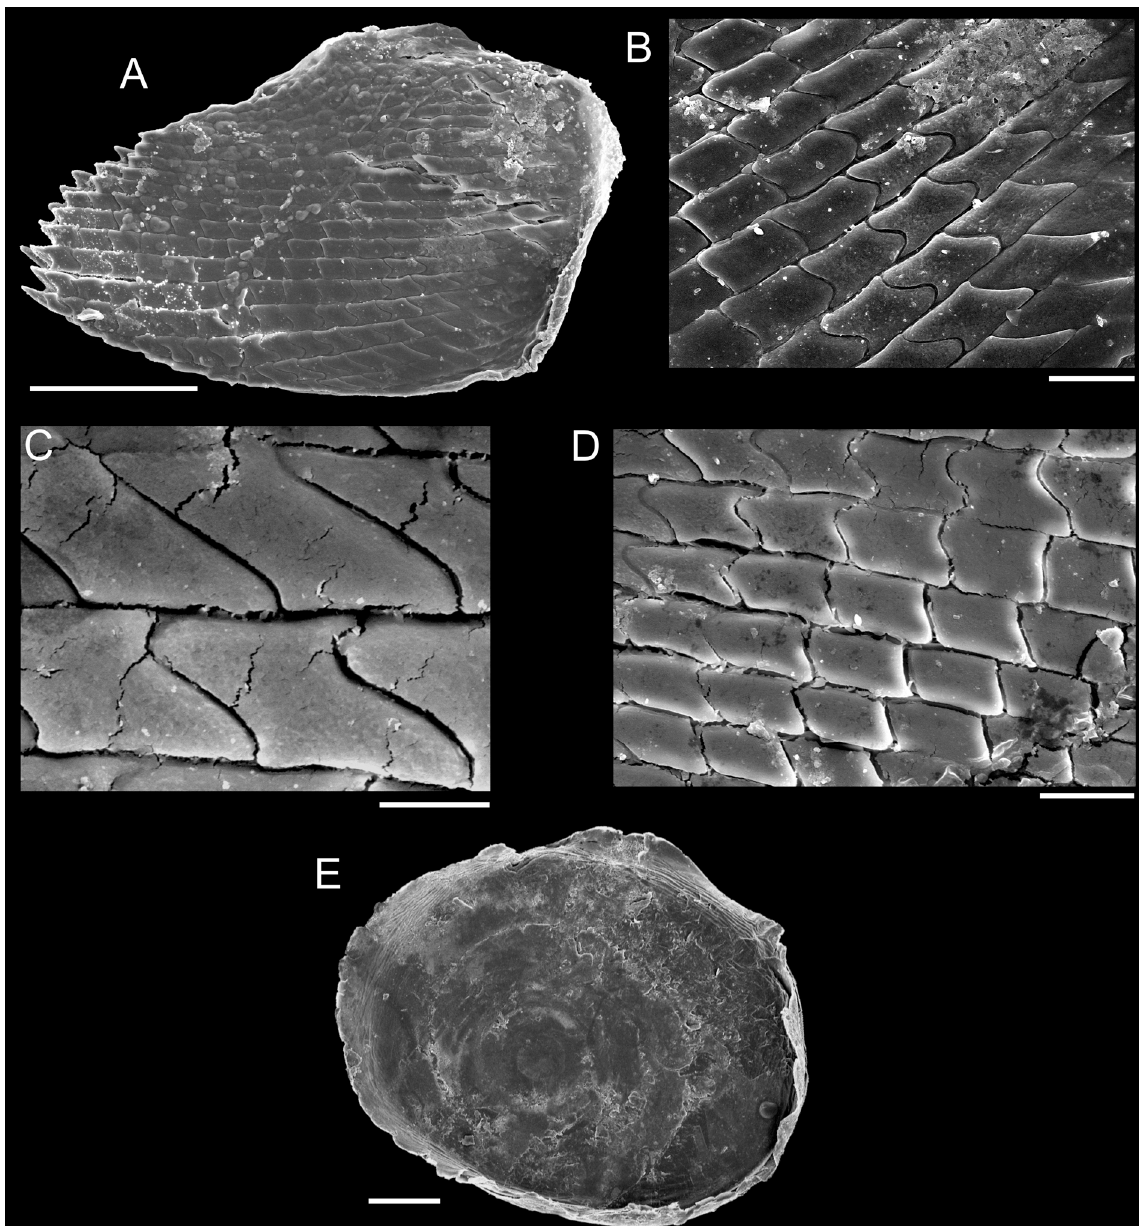
Fig. 5. Cheirodonta dupliniana (Olsson, 1916) comb. nov. A–E . USNM 1438722. A–D . Jaw, outer side. E . Operculum. Scale bars: A = 50 µm; B, D = 10 µm; C = 5 µm; E = 100